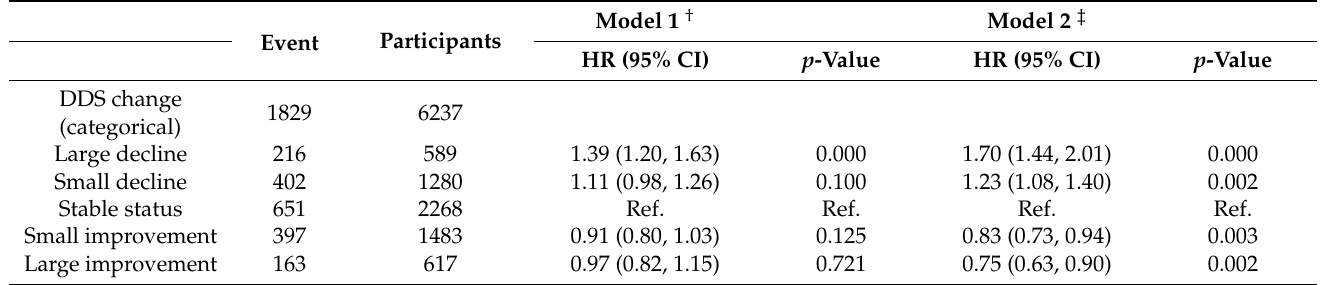
this result might be explained by the survival